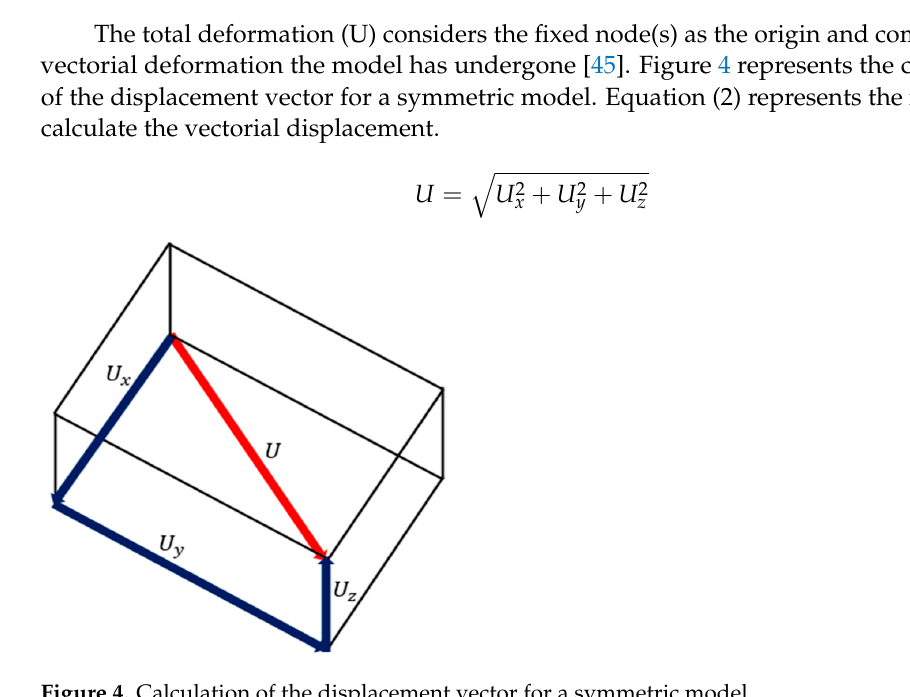
Figure 3. Boundary conditions used in the computational framework. The red arrows show the loading di-rections considered in each simulation.